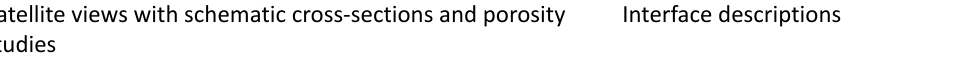
Table 1. (Cont.) Different sequences of Algiers’ current port‐city